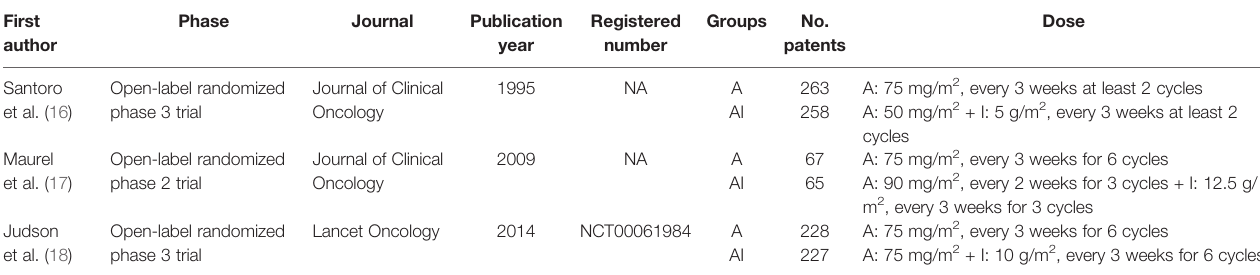
TABLE 1 | Basic characteristics of the eligible clinical trials.